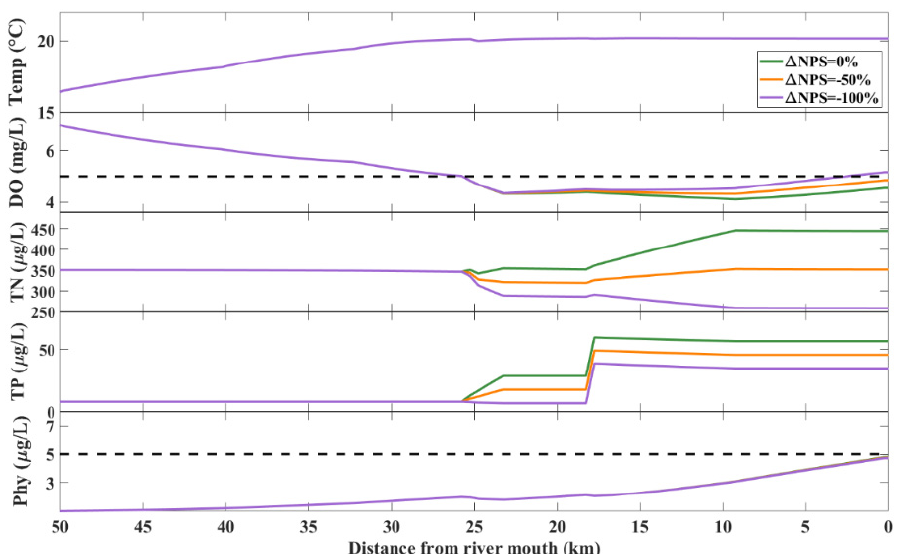
Figure 7. Water temperature/DO/TN/TP/phytoplankton concentration along the Shoalhaven River with the incremental changes (decreases) Δ NPS in NPS reduction from 0% to − 100% but with 2017 air-temperature and streamflow. The black dashed line in the DO concentration is the minimum acceptable level of 5 mg/L, and the black dashed line in the phytoplankton concentration is at 5 µg/L, which is the phytoplankton concentration threshold for an algal bloom.